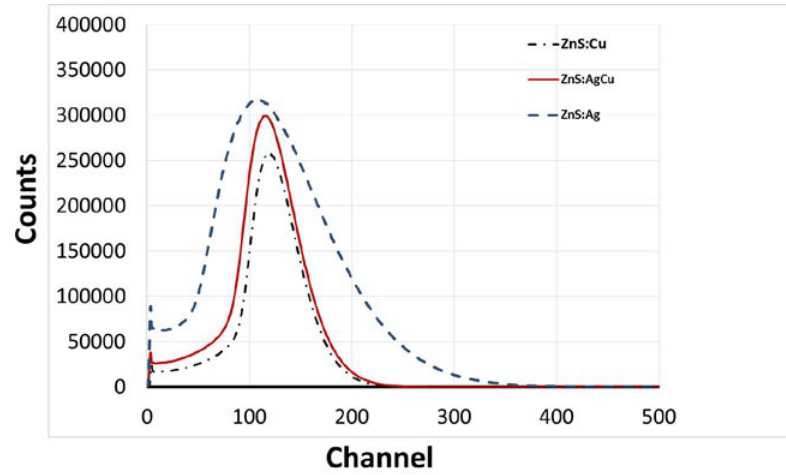
Fig. 7. The pulse height spectra of ZnS with Ag, Cu and AgCu